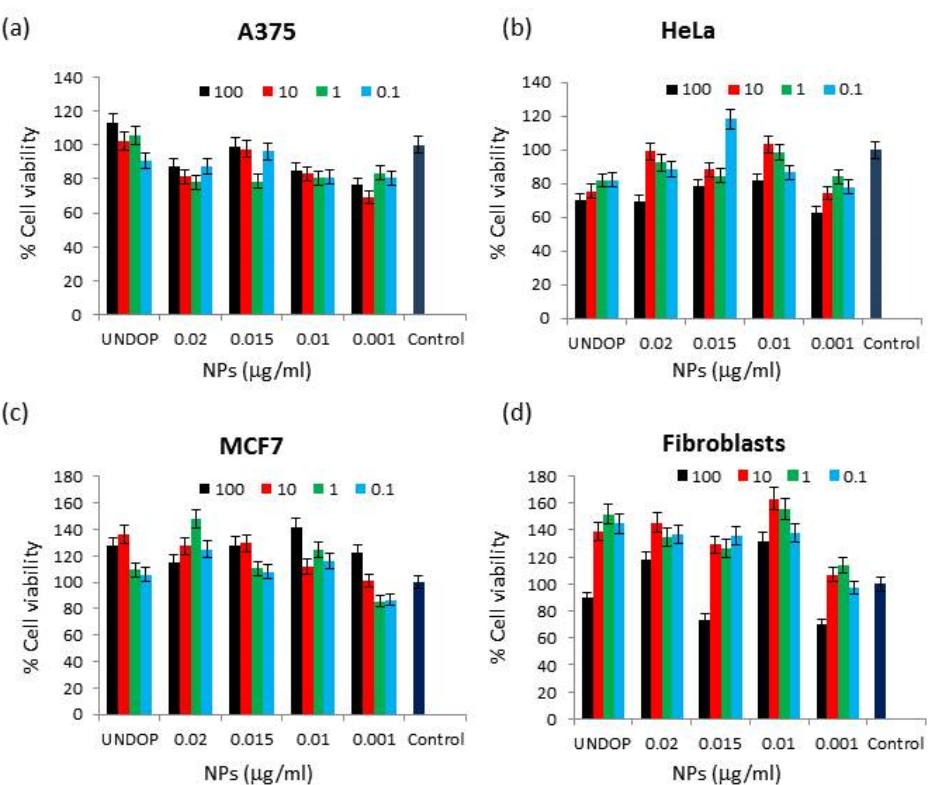
Figure 8. MTT assays results carry out with Tb 3+ containing nanoparticles on A375, HeLa, MCF7 and Fibroblasts cells. A375 ( a ), Hela ( b ), MCF ( c ), Fibroblasts ( d ) cells. Data is displayed as control cells compared to cells treated with nanoparticles prepared at x = 0.020, 0.010, 0.015, and 0.001 M Tb 3+ . The data are presented as means ± s.d. ( n = 3) from three independent experiments using two-way ANOVA.